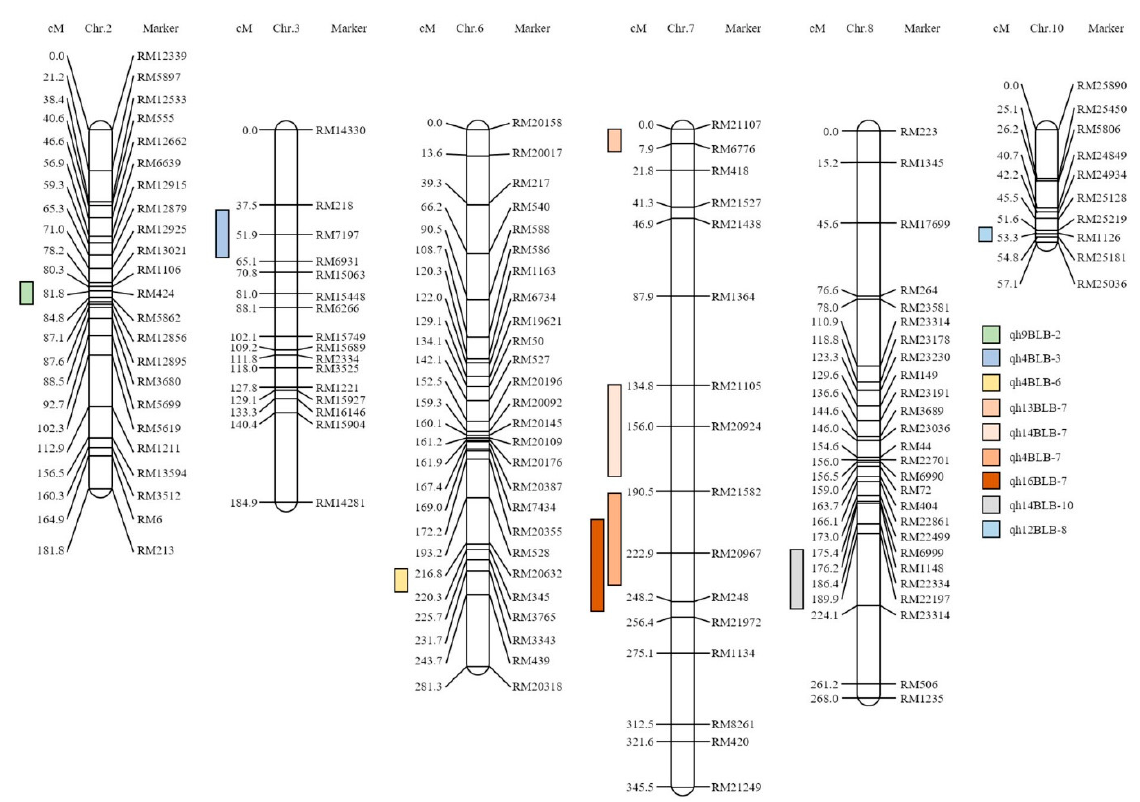
Figure 3. The chromosomal location of the quantitative trait locus (QTL), associated with high-performance liquid chromatography peak area data in the Cheongcheong/Nagdong double haploid genetic map. An LOD score of 3.0 or higher was detected when peak concentrations of 4, 9, 12, 13, 14, and 16 of the 17 metabolites were used. Only QTLs with an LOD score of 3.0 or higher were shown on the genetic map.